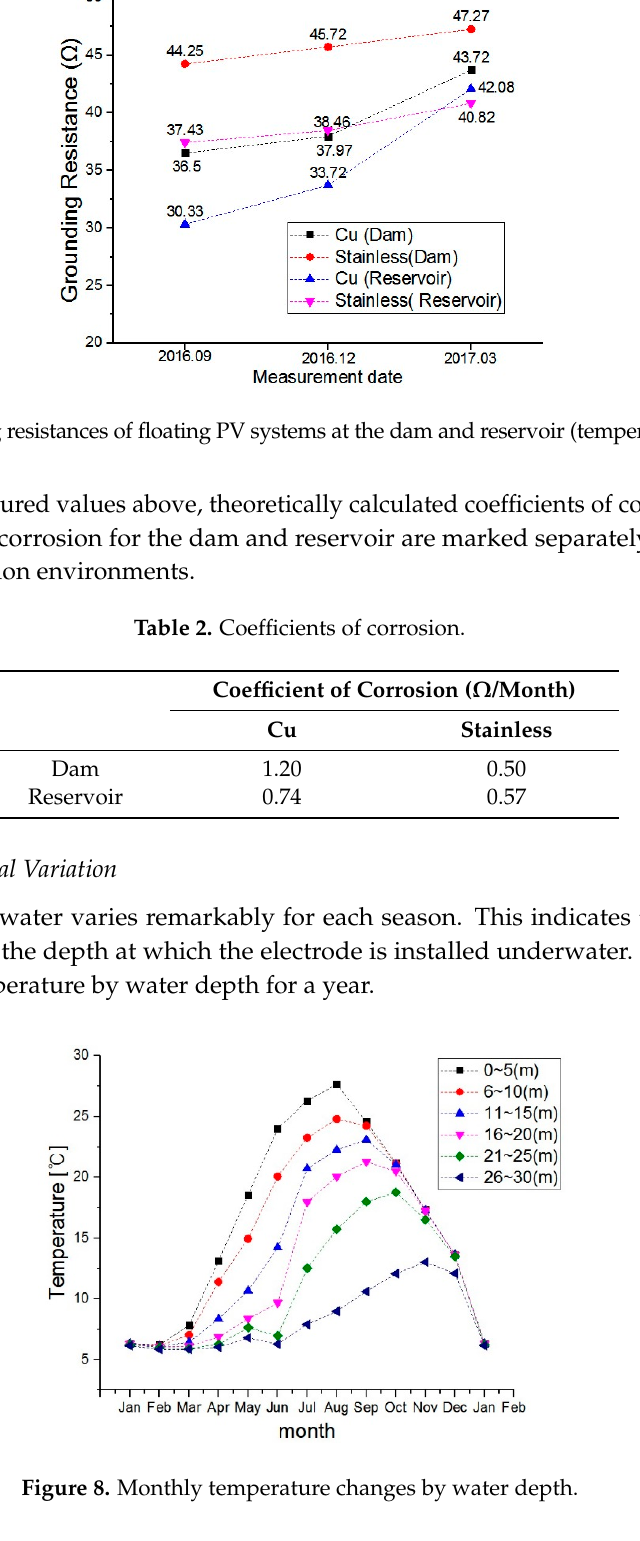
Figure 8. Monthly temperature changes by water depth.